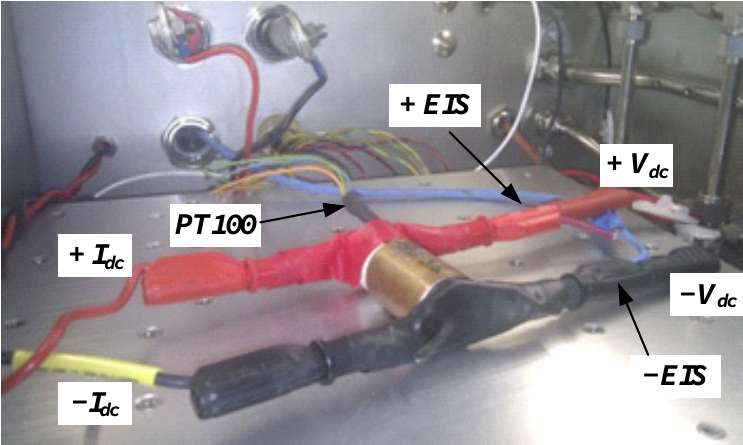
Figure 1. Lithium iron phosphate/graphite (LFP/C) battery during the characterization procedure. EIS: electrochemical impedance spectroscopy.